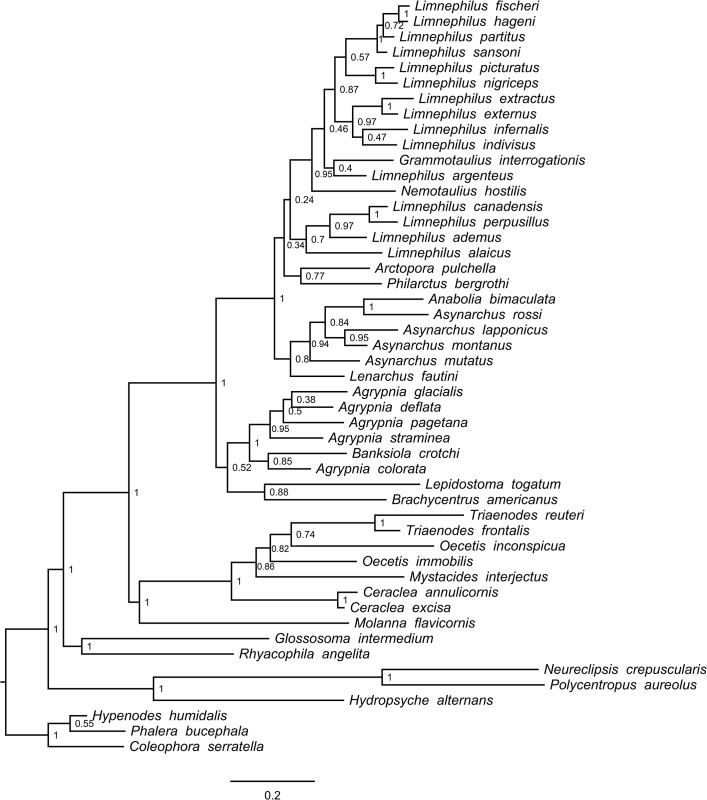
Trichoptera Bayesian tree built with COI and a backbone phylogeny enforced, using family relationships from Holzenthal et al. [19].Node values indicate estimated posterior probabilities from Bayesian analysis.